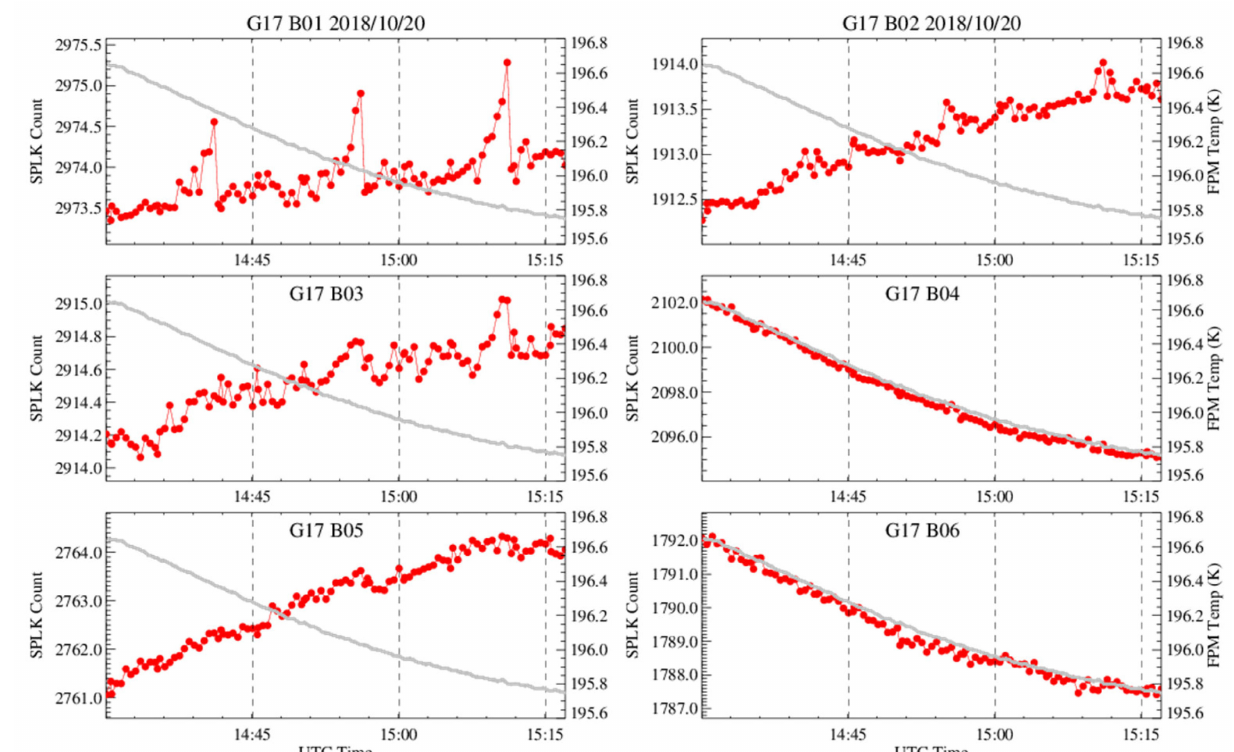
Figure 12. Time series of the mean SPLK values for the G17 VNIR band during the lunar chasing event on 20 October 2018. The vertical dash line is the starting time for each 15 min timeline. The gray line is refers to the second y-axis for the FPM